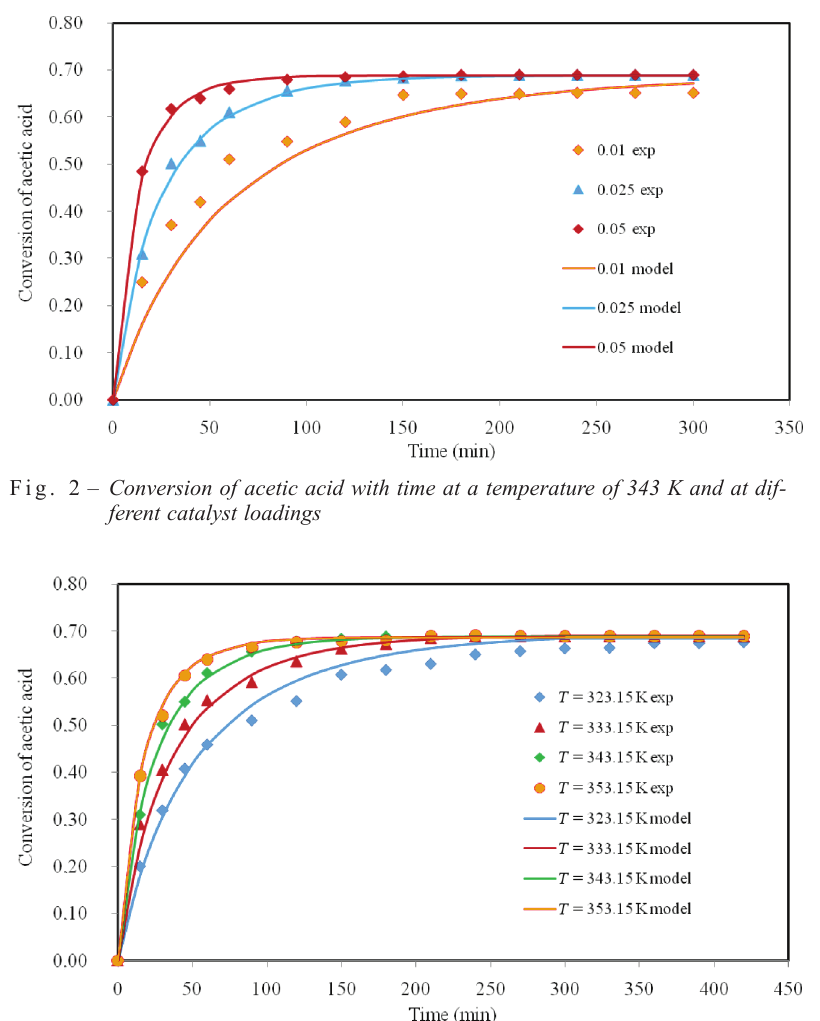
Fig. 3 – Conversion of acetic acid with time at a catalyst loading of 0.025 g mL –1 and at different reaction